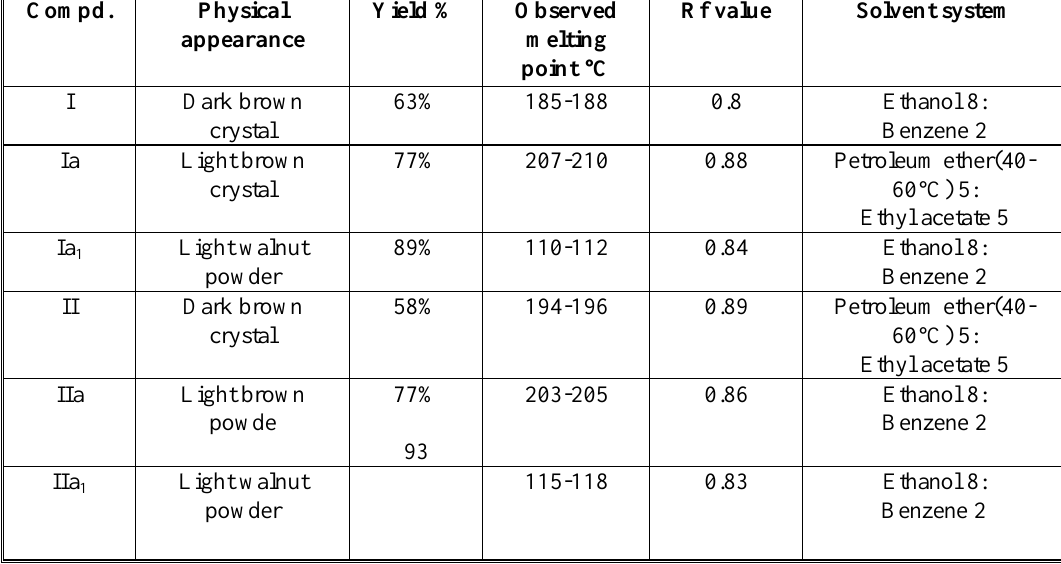
Table (2) The IR characteristic absorption bands of the synthesized compounds IR characteristic absorption bands v ` (cm -1 ) Compd.